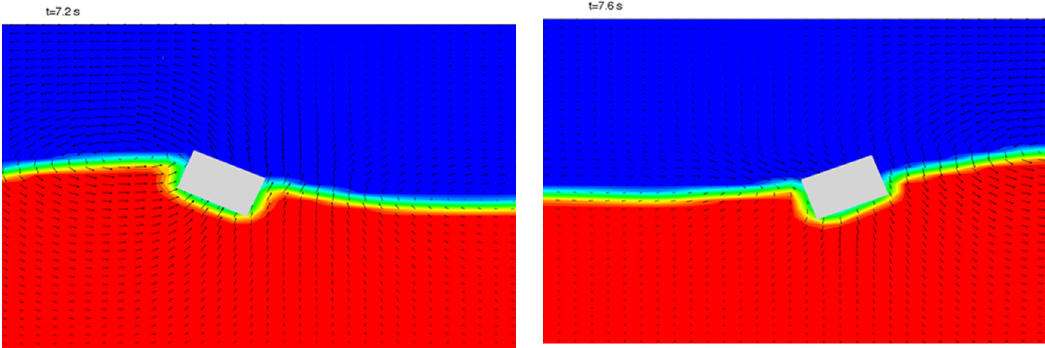
Figure 24. Density distributions and velocity vectors of floating body at t = 7.2 s ( left ) and t = 7.6 s ( right ).